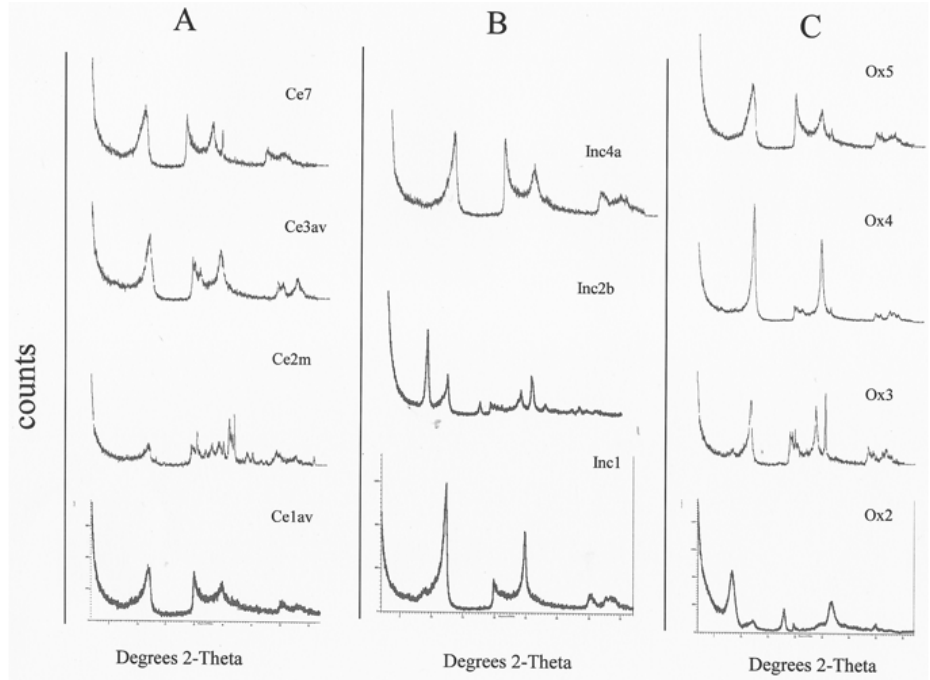
Fig. 3 – XRD-Mineralogical Composition (oriented aggregates) of representative samples of the kaolin clays at A – Ceramarte Mine, B – Incepa Mine, C – Oxford Mine.